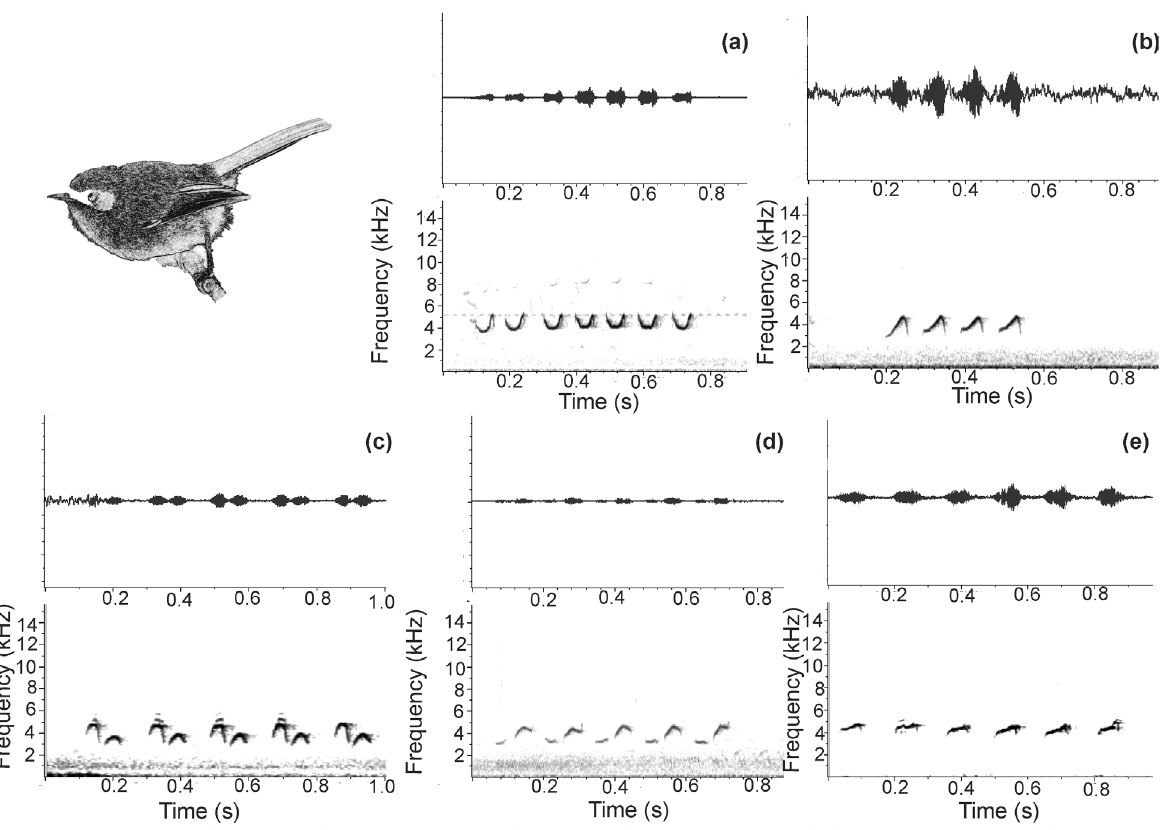
Figure 2. Oscillogram (upper part) and spectrogram (lower part) of call to female (a) and long distance (b), territorial (c), nest building (d) incubation (e) call of P. dumicola